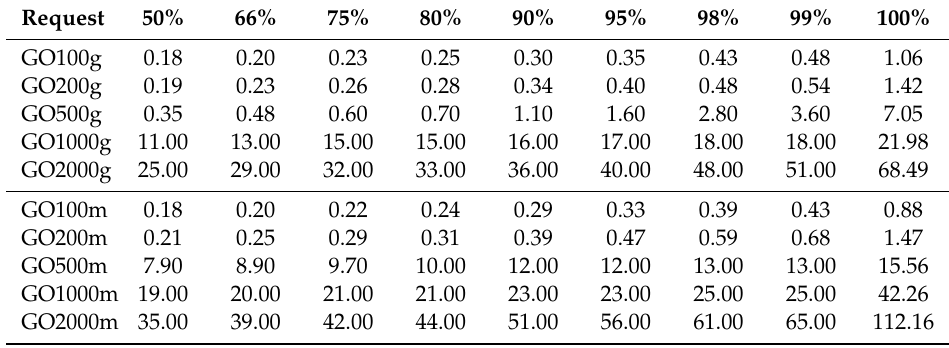
Table 18. Percentage of getObservation requests completed within given times (in seconds) for the different configuration of concurrent users and WSGI server (case C).